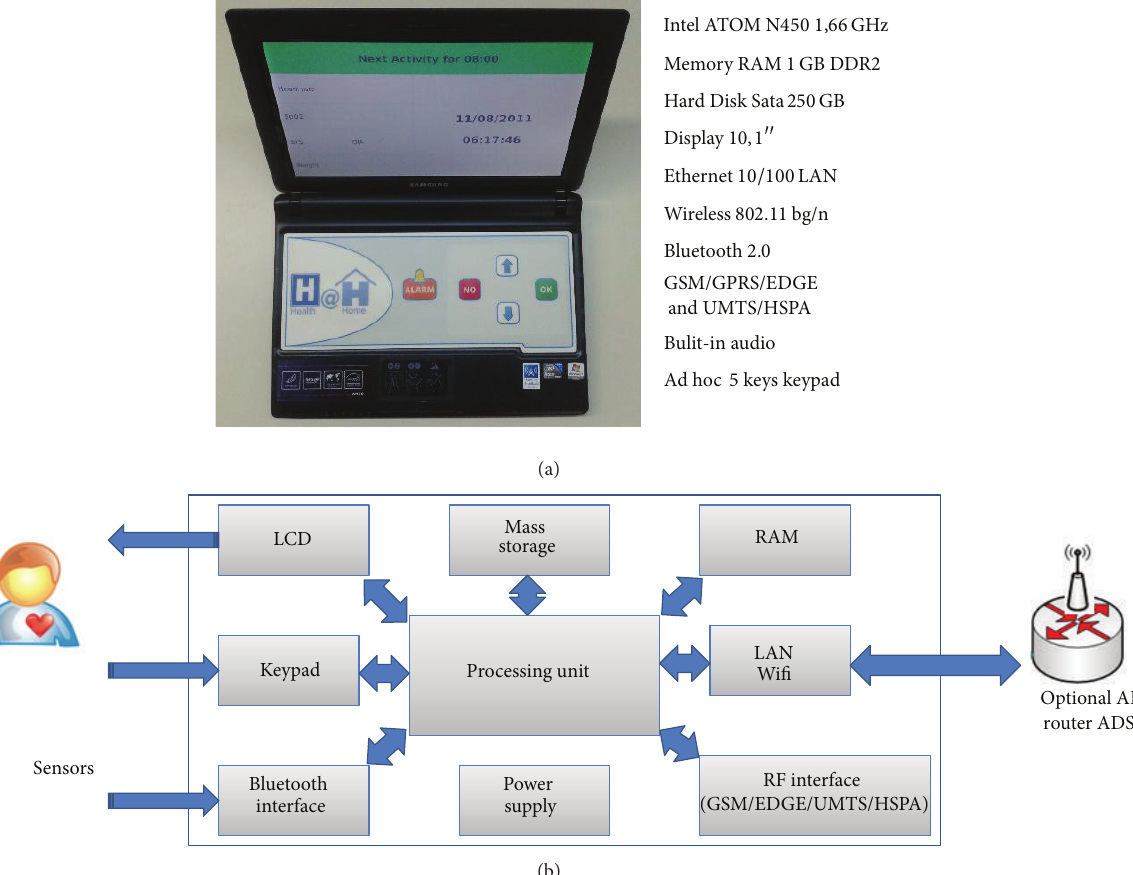
Figure 5: Home gateway architecture and hardware